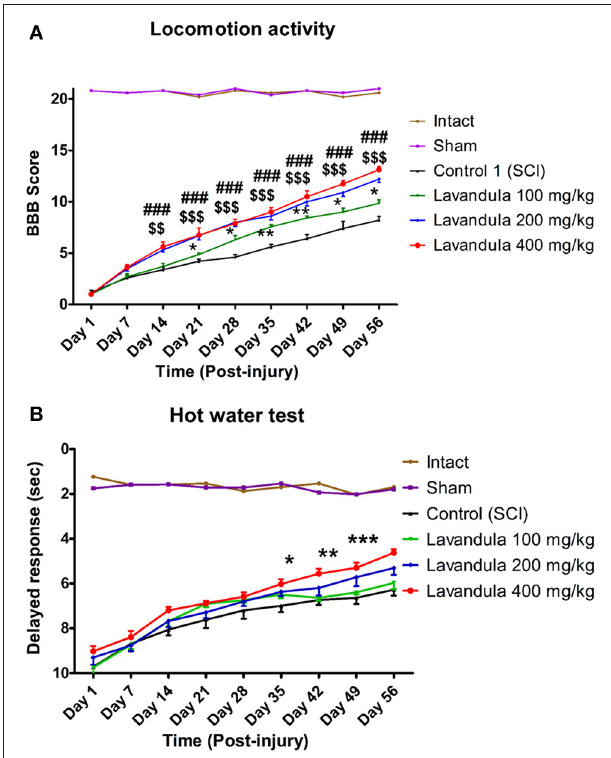
FIGURE 1 | Administration of L. angustifolia extract improves motor and sensory function impairment in the rat spinal cord contusion model. Administration of L. angustifolia extract (i.p.) daily for 14 consecutive days post-injury significantly improved BBB scores (A) and sensory function (with decreased delayed response in the hot-water test) (B) Data are represented as mean ± SEM. (A) ###shows significant difference between Lav 400 and controls (SCI) ( P < 0.001 ). $$ and $$$ show significant differences between Lav 200 and controls (SCI) ( P < 0.01 and P < 0.001 , respectively). * and ** show significant differences between Lav 100 and controls (SCI) ( P < 0.05 and P < 0.01 , respectively). (B) * , ** , and *** show significant differences between Lav 400 and SCI ( P < 0.05 , P < 0.01 , and P < 0.001 ,